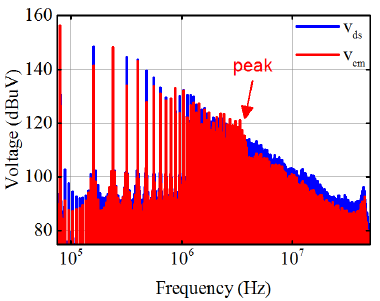
Figure 21. Comparison between calculated spectra of v ds and v cm